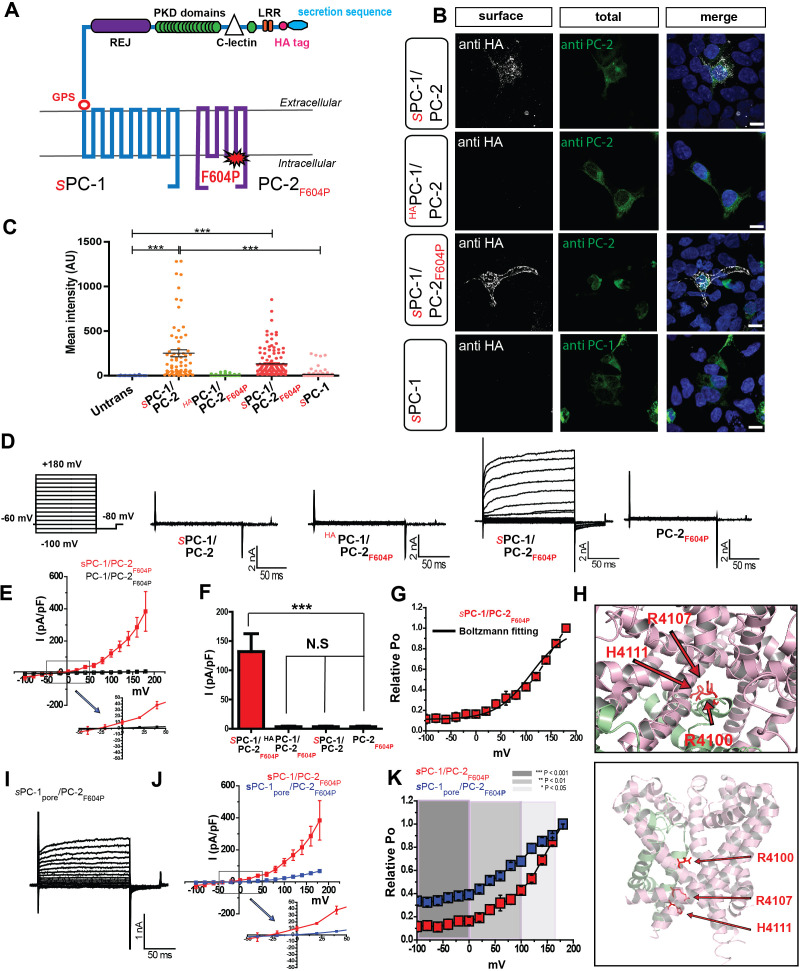
PC-1 and PC-2 form functional channels in the plasma membrane.(A) Illustration of PC-1 and PC-2F604P topology highlighting extracellular HA and secretion sequence (indicated with an s prefix) in PC-1. (B) Expression and immunostaining of HEK293 cells transfected with sPC-1/PC-2, HAPC-1/PC-2 with endogenous leader sequence, sPC-1/PC-2F604P, and sPC-1 alone. Left column, representative images of HA surface staining (see methods). Middle column, total staining for PC-2 or PC-1. Right column, merged images. Scale bar: 10 μm. (C) Quantification of relative anti-HA surface staining shown in B. ***: p<0.0001. (D) Representative currents from each construct recorded in the whole cell patch clamp configuration in response to voltage step pulses (left). (E) Whole-cell I-V relationship of sPC-1/PC-2F604P (n = 6, red) and PC-1/PC-2F604P (n = 10, white). Arrow indicates the expanded view of I-V relationship between membrane potentials of −50 mV and +50 mV. (F) Current densities for sPC-1/PC-2F604P, HAPC-1/PC-2F604P, sPC-1/PC-2, and PC-2F604P alone at +100 mV. (G) Relative open probability of sPC-1/PC-2F604P at −80 mV calculated using a Boltzmann distribution fitted to I/Imin of tail current amplitudes, black line (n = 6, red). (H) Top view of the human PC-1/PC-2 polycystin complex using pymol (Su et al., 2018). Positively charged R4100, R4107, and H4111 are highlighted in red and displayed in stick shape (top). Side view of selectivity filter showing the location of three positively charged amino acids on PC-1 TM-11 (bottom). (I) Representative whole cell currents of sPC-1pore/PC-2F604P. (J) I-V relationship of sPC-1/PC-2F604P (n = 6, red) and sPC-1pore/PC-2F604P (n = 6, blue). Arrow indicates the expanded view of I-V relationship between −50 mV and +50 mV. Current densities of sPC-1/PC-2F604P and sPC-1pore/PC-2F604P were compared at +100 mV holding potential. (K) Relative open probability analysis of sPC-1/PC-2F604P (n = 6, red) and sPC-1pore/PC-2F604P (n = 6, blue) during a −80 mV tail pulse. Statistical significance is indicated by the background. ***p<0.001 (dark gray), **p<0.01 (gray), *p<0.05 (light gray). Statistical analysis was computed using student t-test unpaired one-pair.